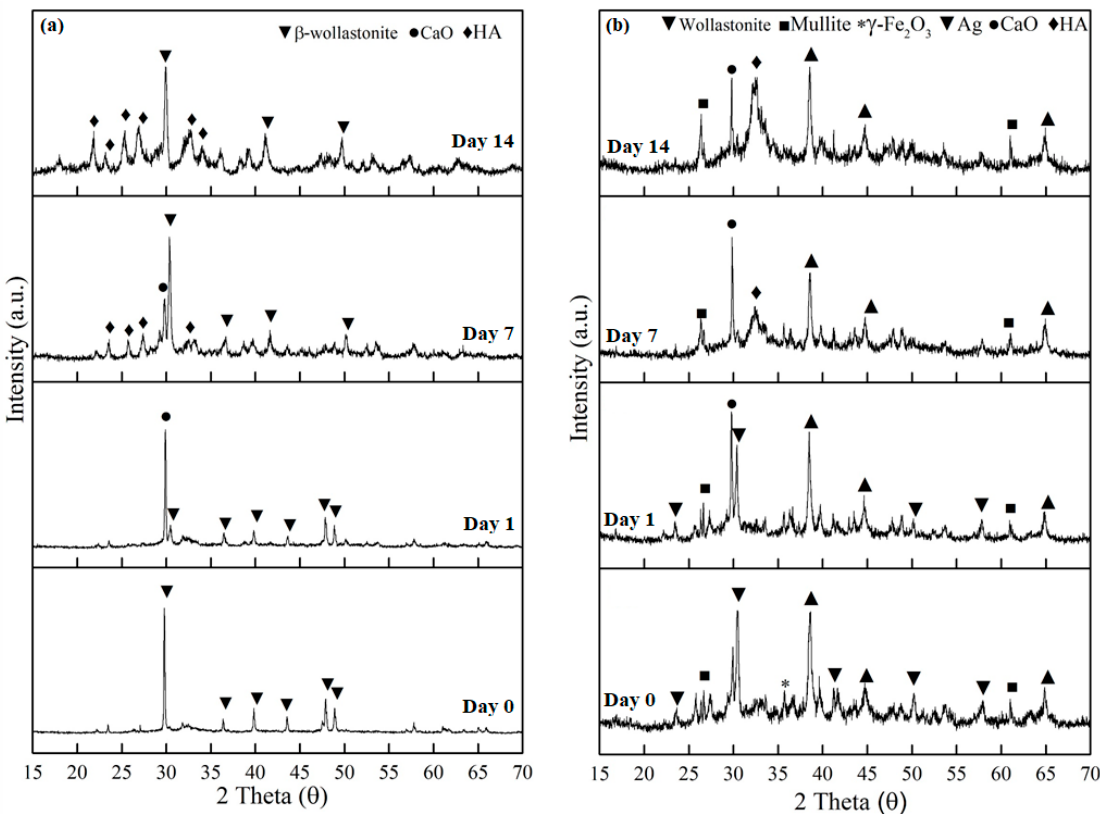
Figure 4. The XRD patterns of the ( a ) β W and ( b ) β WMAF before and after soaking until day 14 in an SBF solution.